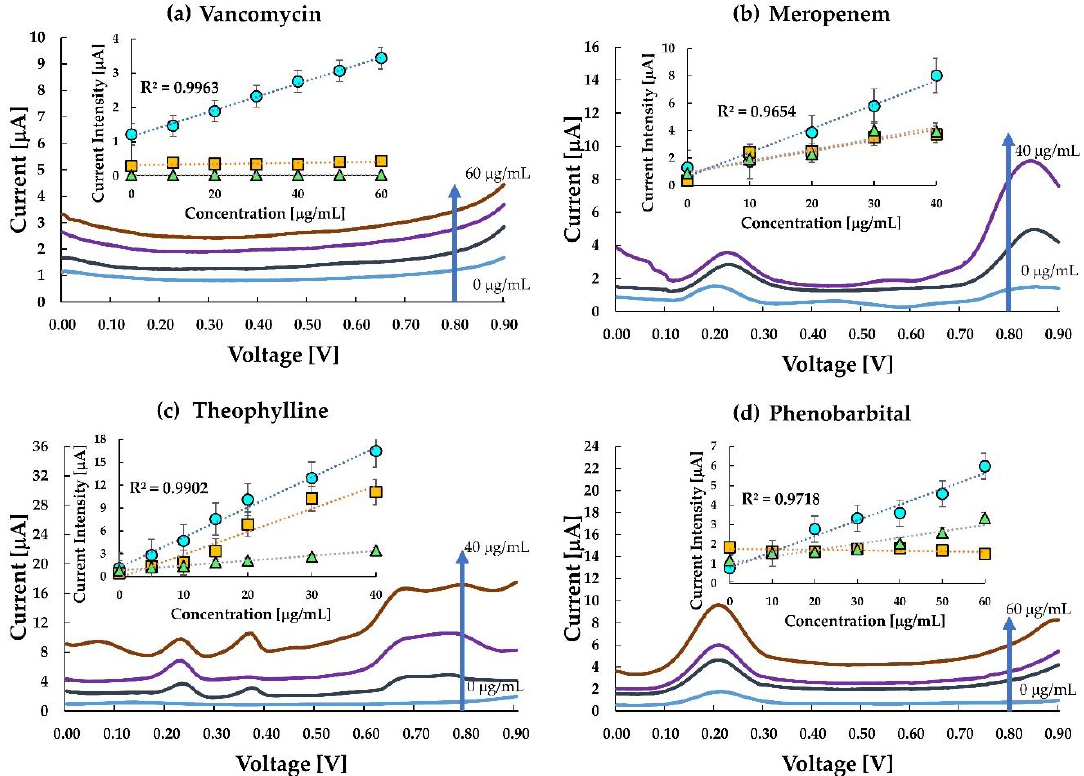
Figure 4. Electroanalysis of the chip sensors for ( a ) vancomycin, ( b ) meropenem, ( c ) theophylline, and ( d ) phenobarbital. The differential pulse voltammograms of the response of MIP to buffer saline in each drug is shown. Insets show the calibration curve for comparison between responses in MIP (circle), non-imprinted polymer (NIP) (square), and untreated carbon paste (triangle) electrodes for each drug. No carbon paste electrodes contained ferrocene.